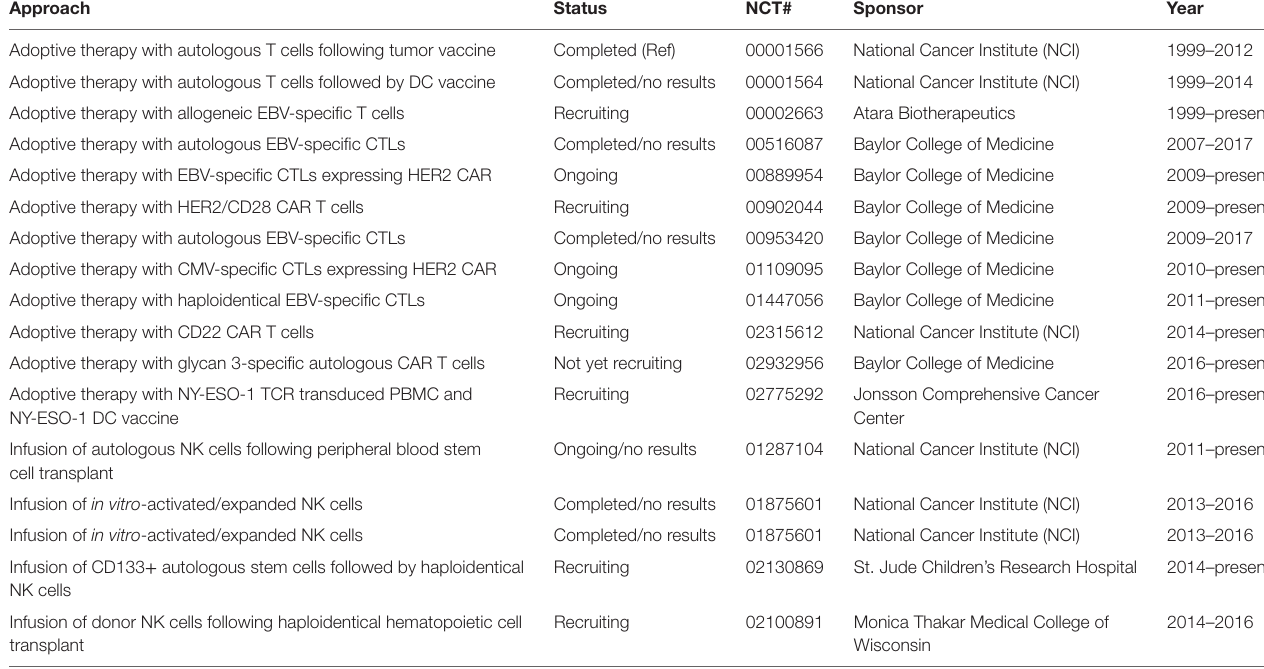
tAble 2 | Present and past adoptive immunotherapy for pediatric central nervous system tumors, sarcomas, and nasopharyngeal carcinomas.